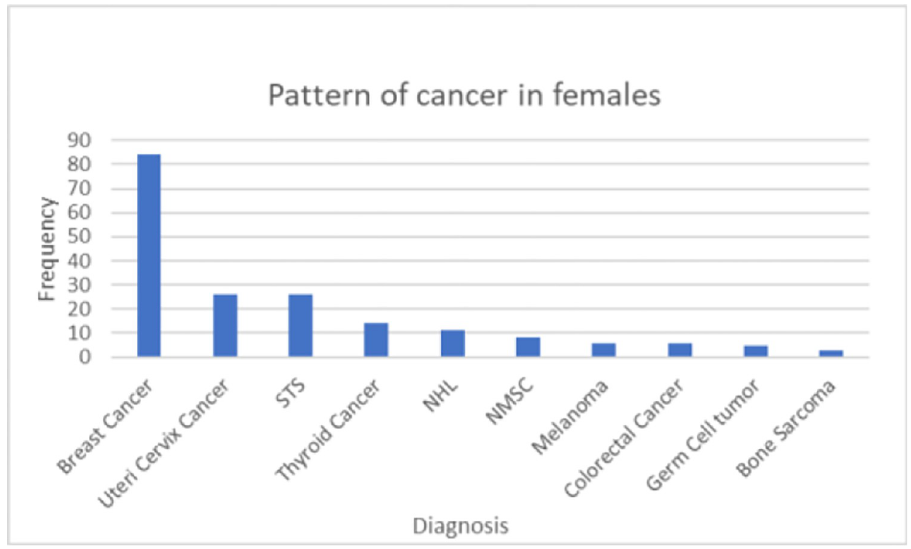
Fig 1. Cancer distribution pattern in females at Wolaita Sodo University Hospital, 2021. NMSC—Non Melanomatous Skin cancer, NHL- Non-Hodgkin lymphoma, STS—Soft tissue sarcoma.